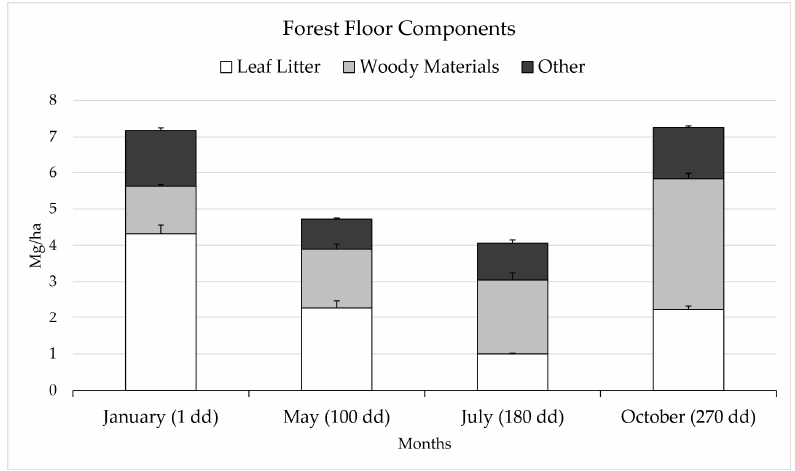
Figure 1. Quantitative and qualitative dynamics of the forest floor components. Months and decomposition days (dd, in parentheses) in the litterbag experiment are reported. Bars represent mean ± standard error of the mean ( N = 6).